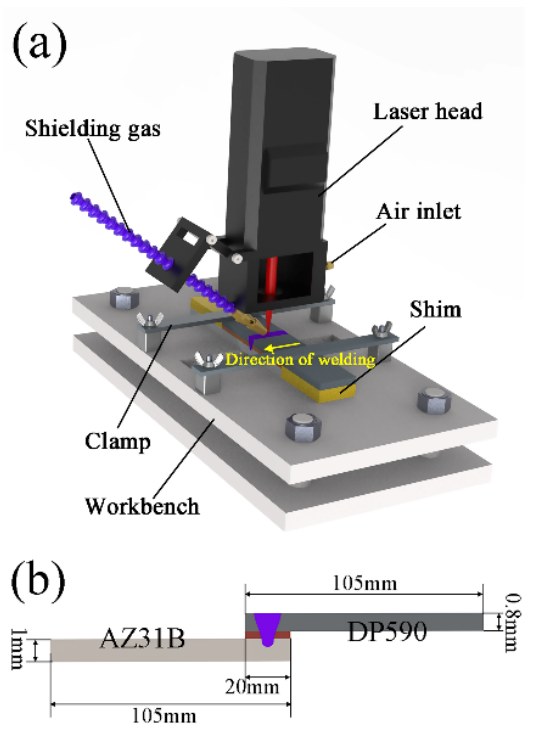
Figure 1. Schematic diagram of laser welding: ( a ) overall schematic diagram and ( b ) schematic diagram of lap joint.